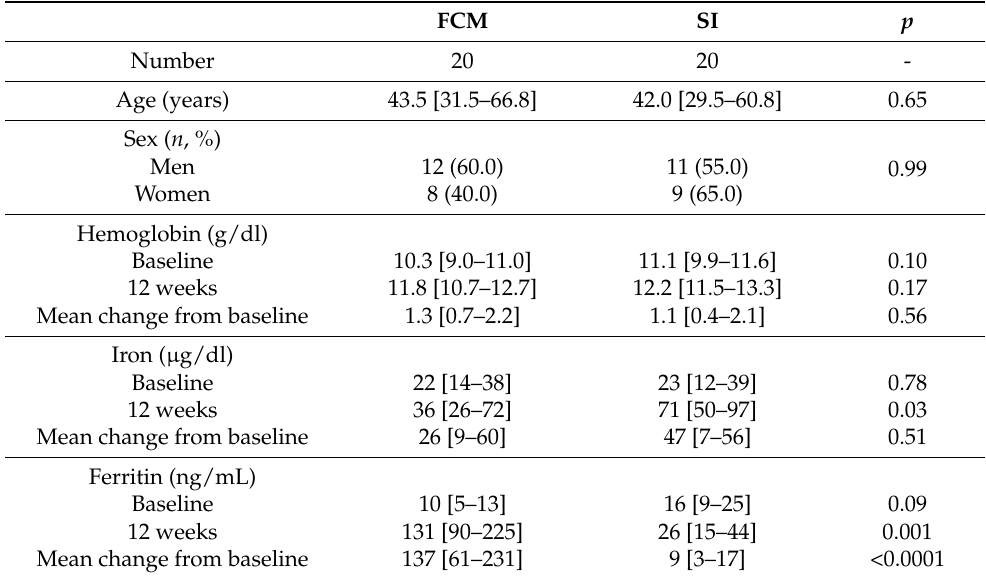
Table 1. Characteristics of the study participants treated with ferric carboxy-maltose (FCM) or sucrosomial ® iron